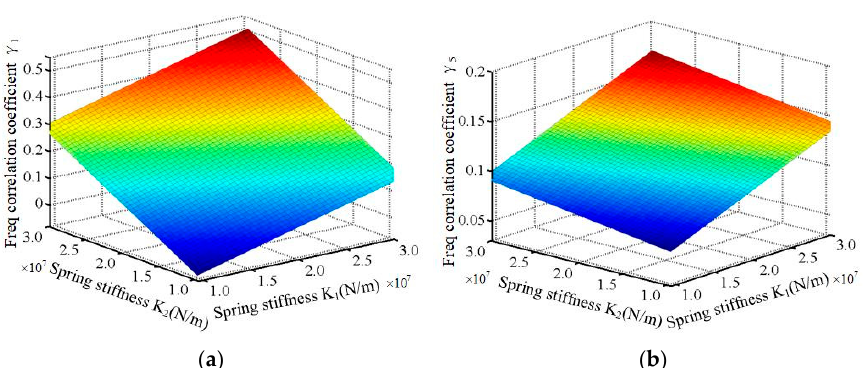
Figure 9. Response surface of γ 1 and γ 5 under different spring element stiffness. ( a ) The first mode. ( b ) The fifth mode.